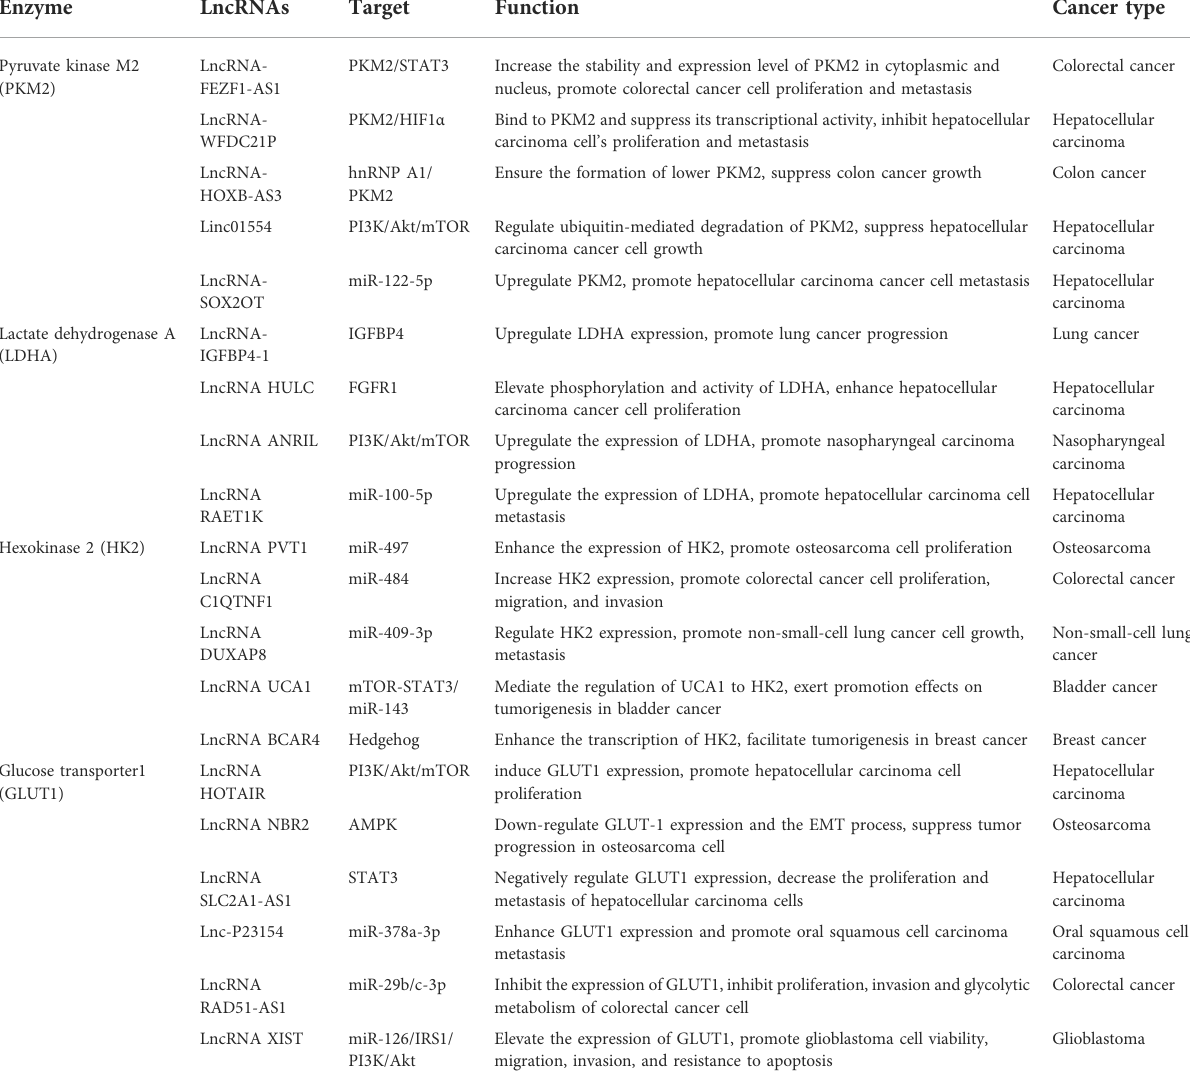
TABLE 1 Overview of LncRNAs related to the enzymes of aerobic glycolysis in cancer.